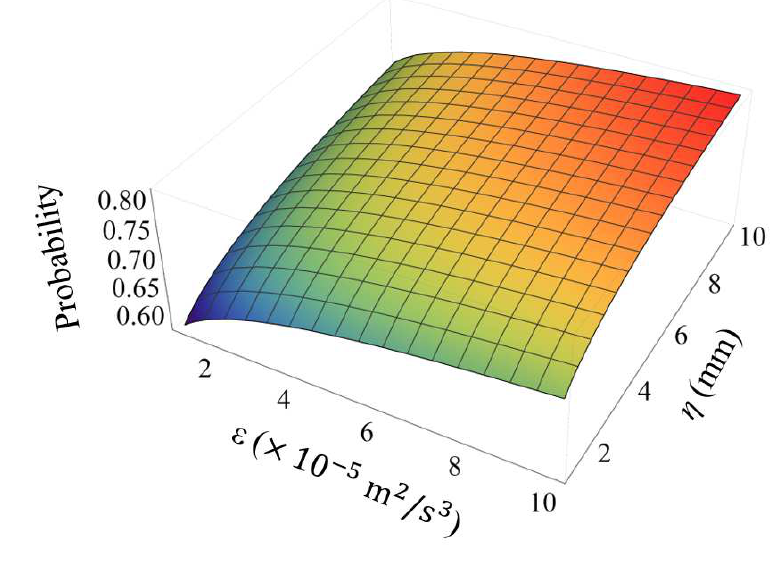
Figure 5. The normalized transmitting probability of the signal vortex modes versus dissipation rate of kinetic energy per unit mass of fluid ε and inner scale of turbulence η